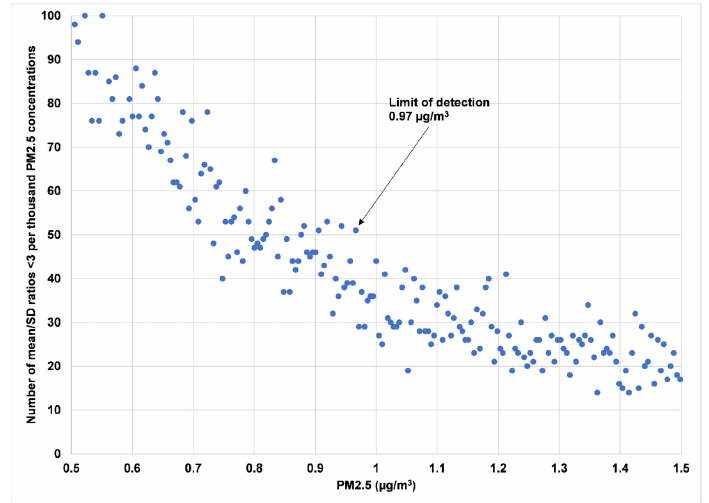
Figure 16. The number of mean/SD ratios per thousand “batches” of ordered contiguous measured concentrations steadily declines with increasing concentration. When this function falls below 50 and does not exceed 50 at any higher concentration, the LOD is considered to be the “last” (largest) concentration with at least 50 ratios <3. A summary of the estimated preliminary and final infiltration estimates, along with the calculated outdoor-infiltrated and indoor-generated concentrations for all six cases is offered (Table 7). Table 7. Infiltration factors (F inf ) and mean PM 2.5 for outdoor-infiltrated (Out inf ) and indoor-gener- ated (In gen ) particles, including the percent contribution to total indoor PM 2.5 from the indoor-gen- erated particles (In gen (%)). These variables are shown for the entire datasets and for the subsets (1 and 2) created when the Forbidden Zone was violated by too many observations. Outdoor Site